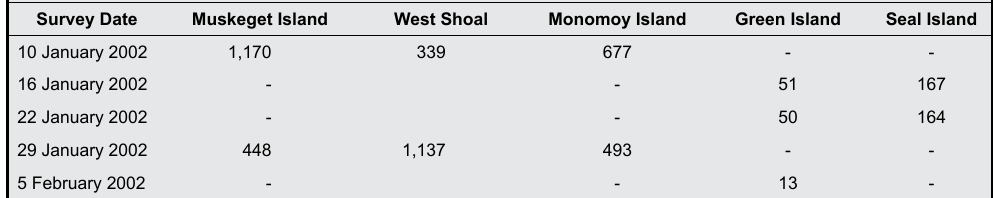
Table 2. Average number of grey seal adults counted at each of the 5 sites surveyed for each survey